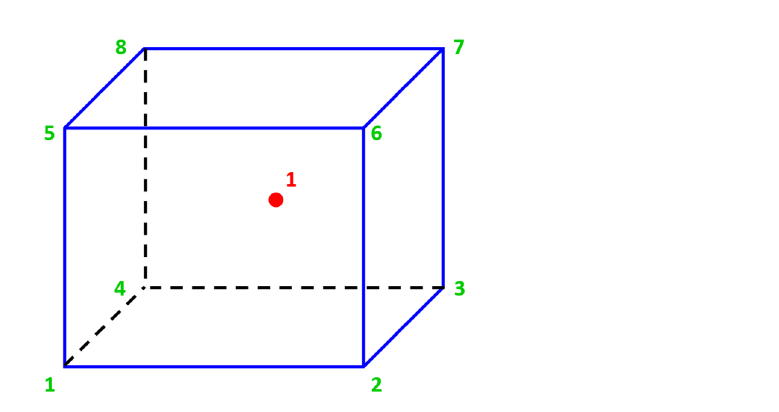
Figure 3. Representation of the 1 × 1 × 1 integration points scheme in hexahedral elements.